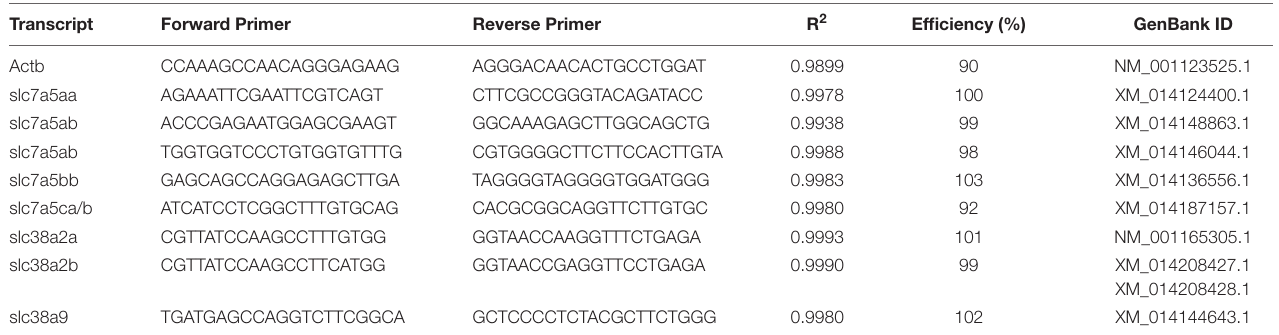
TABLE 4 | Primers sequences used to evaluate mRNA abundance by quantitative RT-PCR